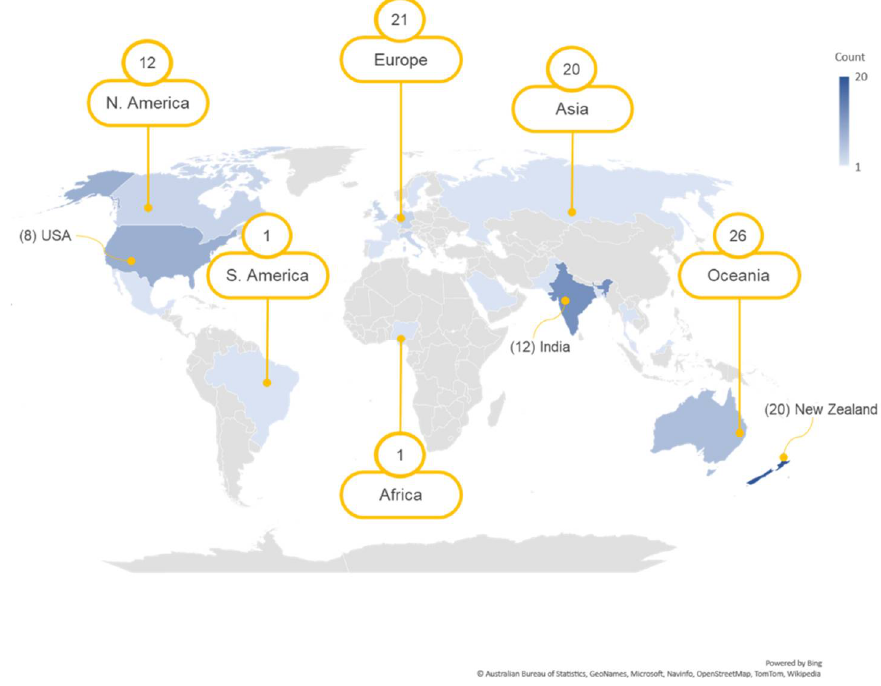
Figure 3. Location of respondents’ projects/research work.